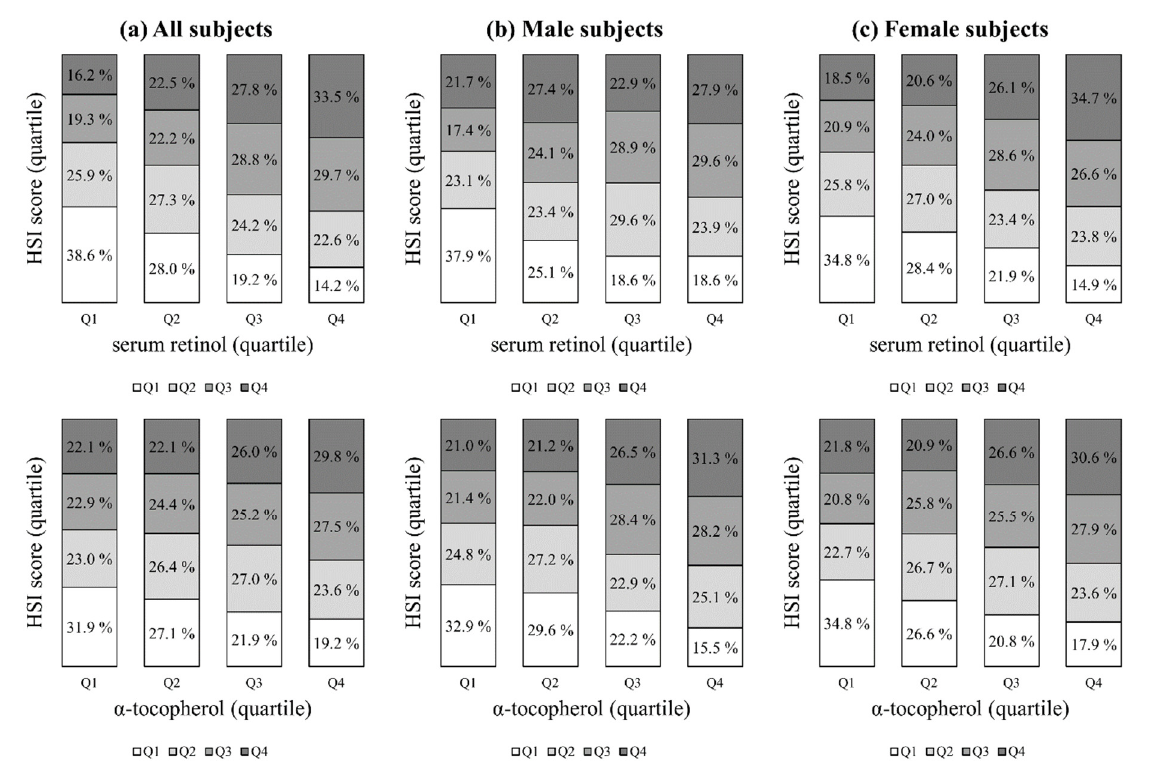
Figure 2. Proportion of subjects with serum retinol and α -tocopherol levels according to quartile with predicted NAFLD prevalence (HSI) by quartile. The study population was divided into quartile groups according to NAFLD (HSI) and vitamin (serum retinol and α -tocopherol) levels, respectively. Serum retinol and α -tocopherol had strong positive associations with the NAFLD (HSI) prediction model ( p s < 0.0001 for the trends). NAFLD, non-alcoholic fatty liver disease; HSI, hepatic steatosis index; Q, quartile.